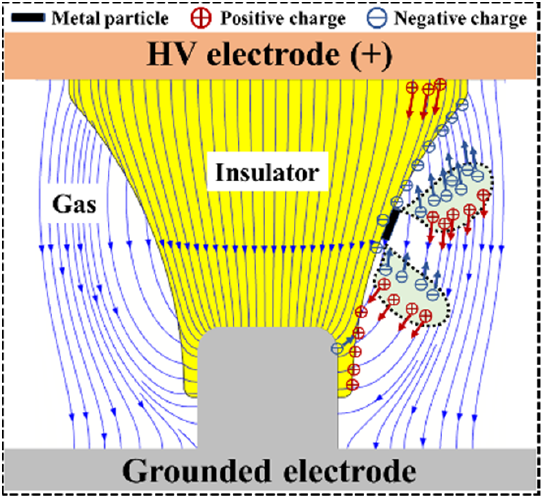
Figure 6. Surface charge accumulation process of tri–post epoxy insulator in clean state.